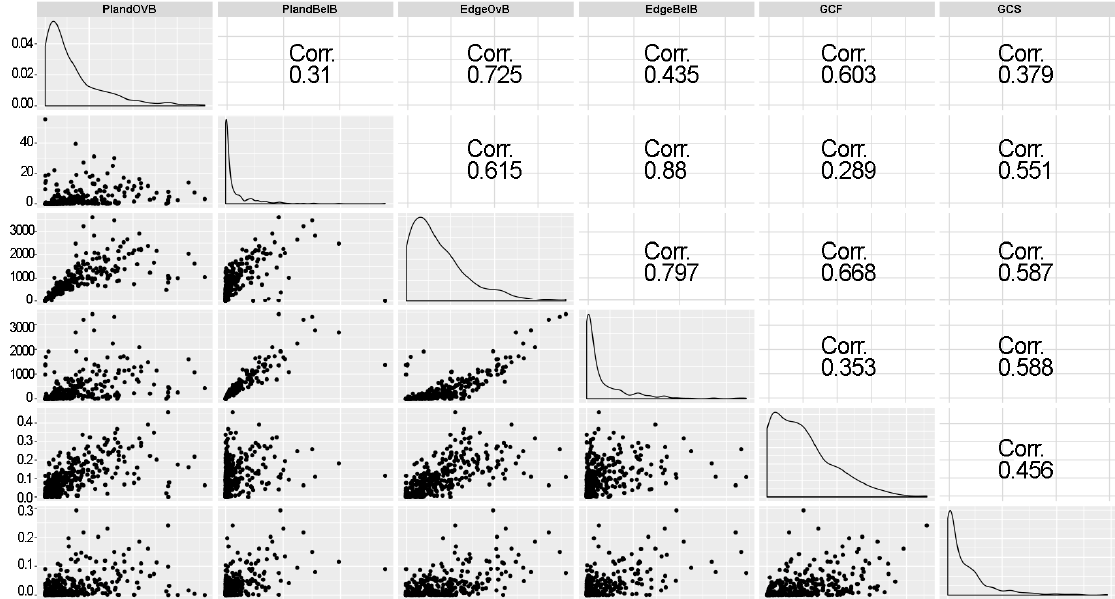
Figure 10. Correlation matrix. Main diagonal graph are the frequency distribution of variables. Cells above the main diagonal show the correlation coefficients. Graph above the main diagonal is the scatter plot of the variables.